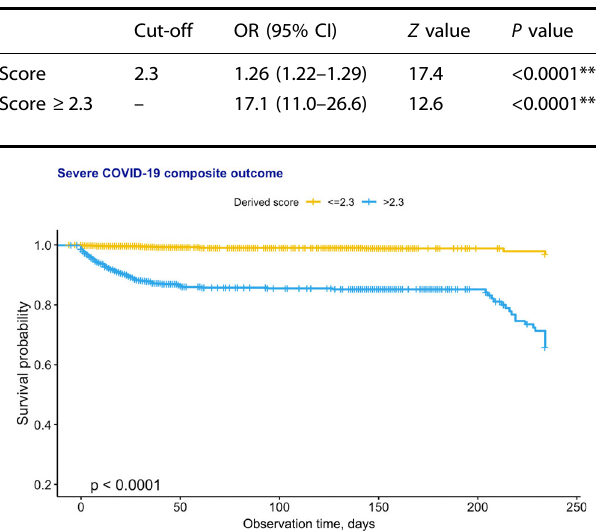
Fig. 2 Survival anlysis for the cohort from Hong Kong, China. Survival curve of COVID-19 patients strati fi ed by dichotomized risk cohort: top panel; Wuhan cohort: bottom panel). As the Wuhan cohort did not routinely have AST tested, this variable was excluded for the performance comparisons. The AUC of 0.86 for the Hong Kong cohort ( fi vefold cross-validation) and 0.89 for the Wuhan cohort.